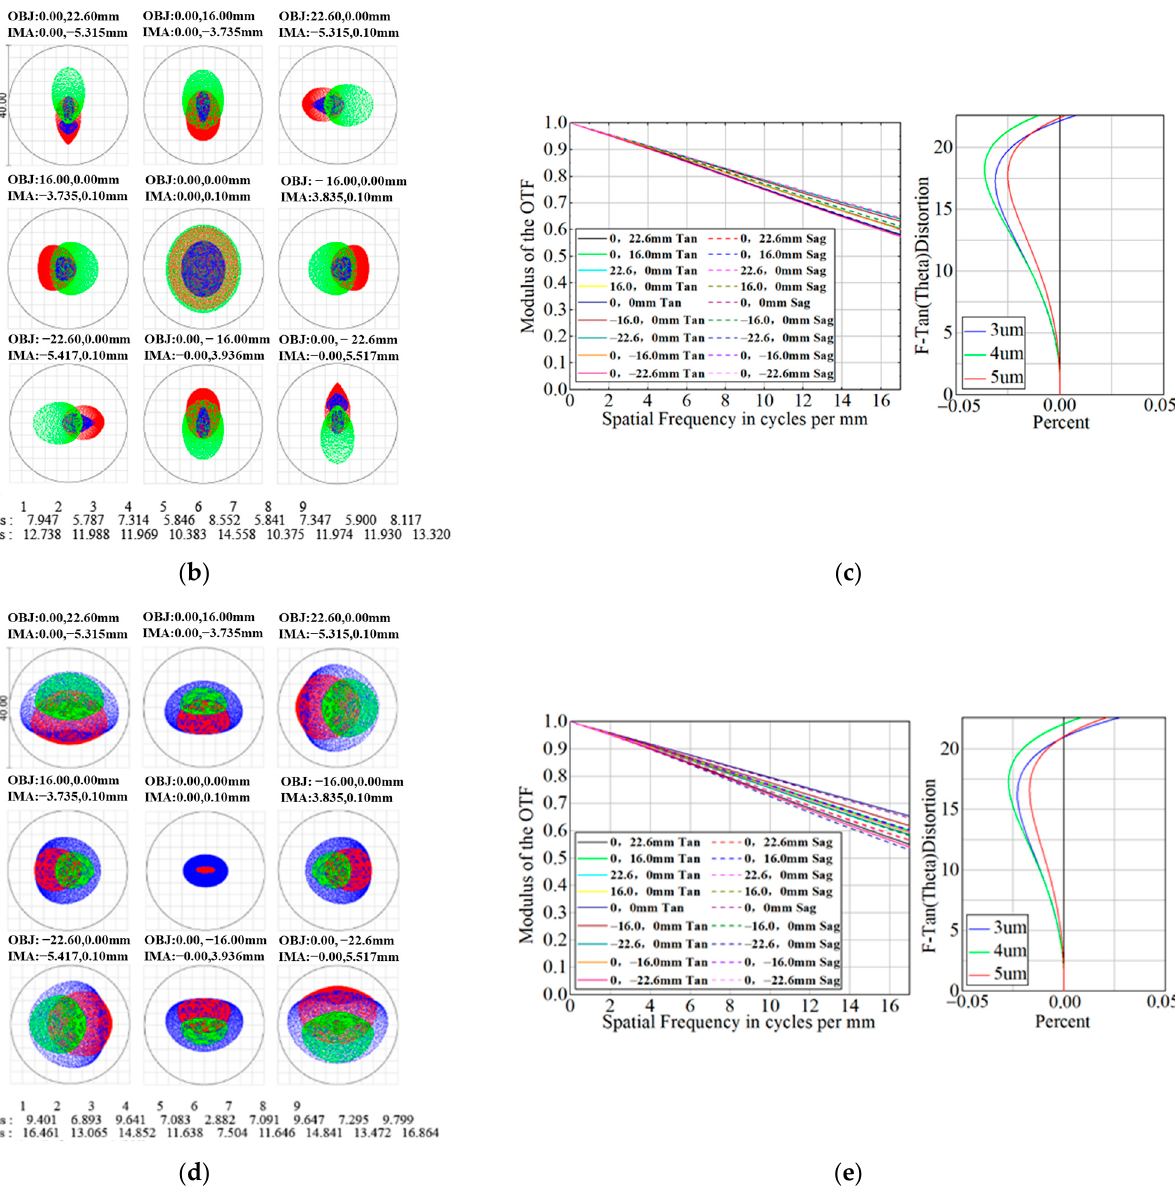
Figure 6. RS design results: ( a ) the SR layout; ( b ) spot diagram at the object field depth of 960 μ m; ( c ) MTF and distortion curve of RS at the object field depth of 960 μ m; ( d ) spot diagram at the object field depth of − 960 μ m; ( e ) MTF and distortion curve of RS at the object field depth of − 960 μ m.